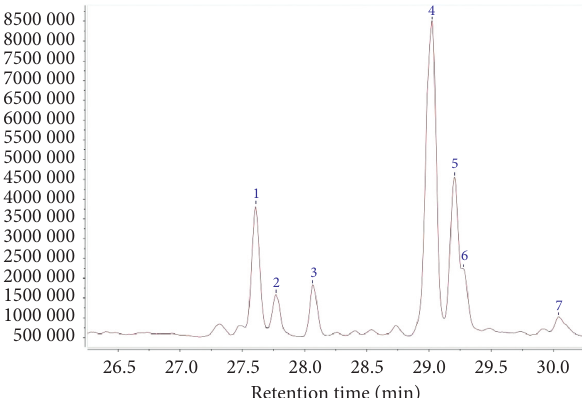
Figure 2: The chromatogram presents the sterol blue corn line profile CHIH 503 (1—campesterol, 2—stigmastanol, 3—stigmasterol, 4— β - sitosterol, 5—stigmastanol, 6—campestanol, and